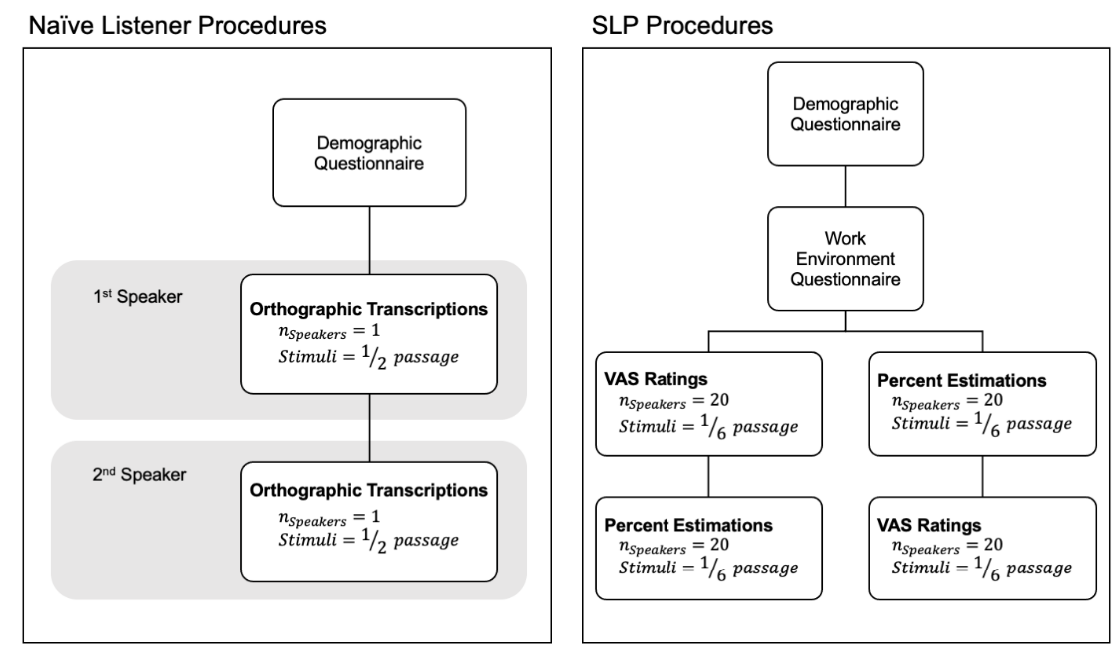
Figure 1. Study Procedures for the SLP and Naïve Listeners. Passage refers to segments of The Grandfather passage. Consent was obtained prior to the study procedures depicted in this figure. VAS = visual analog scale ratings